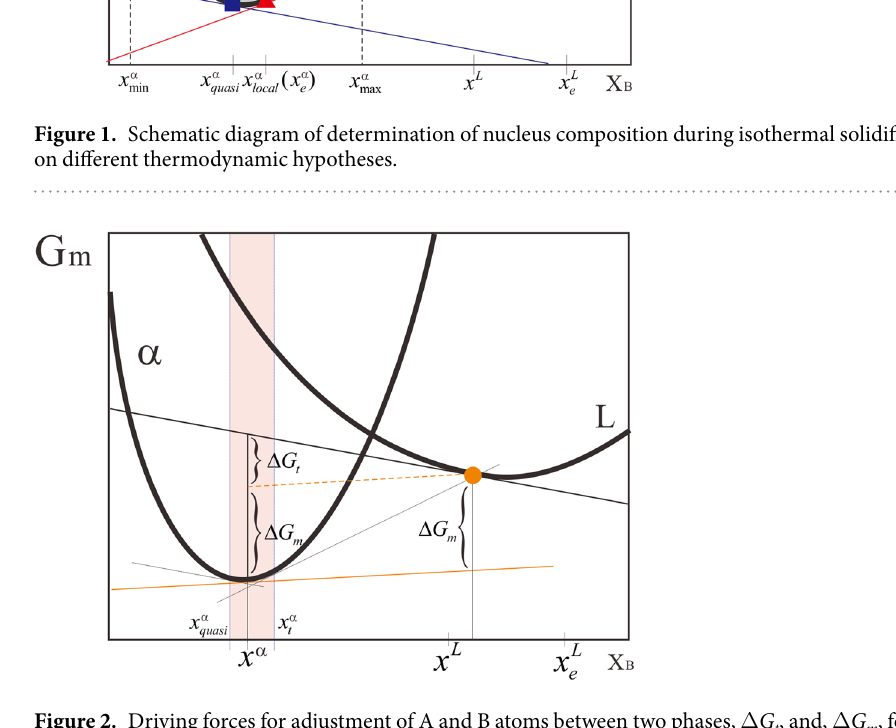
Figure 2. Driving forces for adjustment of A and B atoms between two phases, Δ G t , and, Δ G m , for precipitation of α from a supersaturated liquid x L